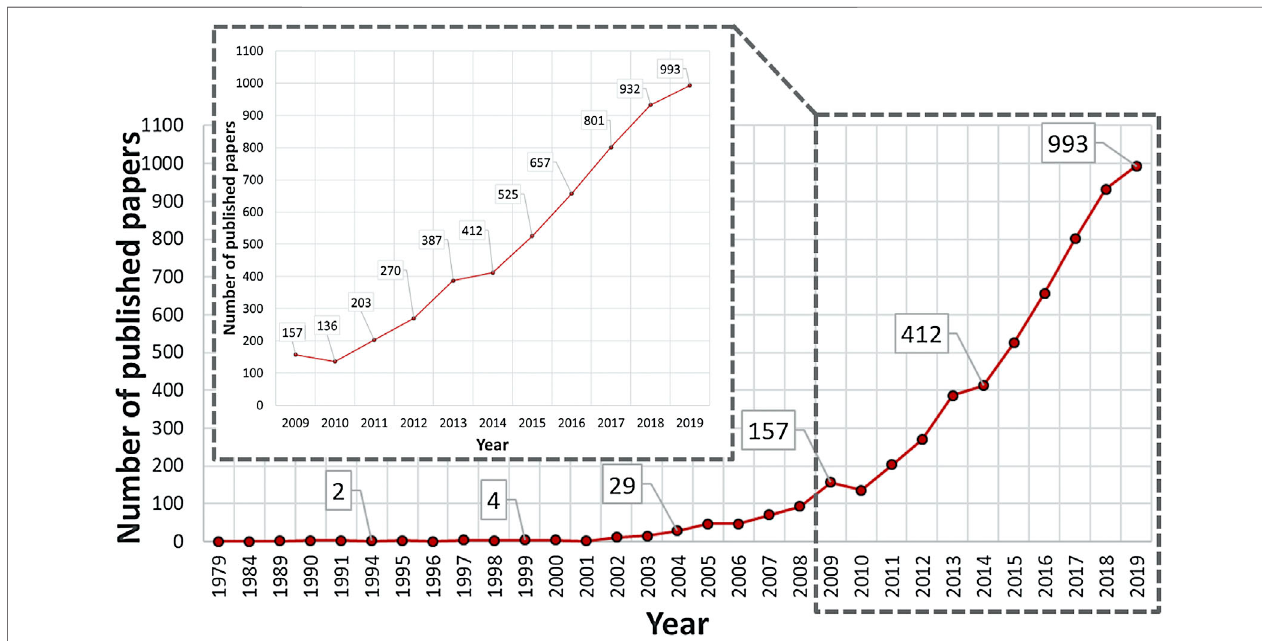
FIGURE 1 | Distribution of the published works on the topic of alkali-activated materials (including geopolymers). In the inlay, distribution of publications in the last 10 years is reported (2009 – 2019).